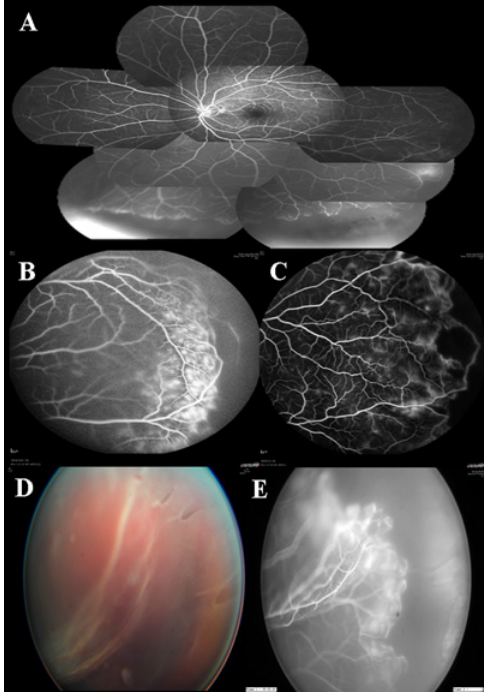
Fig 3. Color fundus and FA photos of group 3 eyes (A) Fluorescein angiography of an eye with group 3 retinal vasculature. Note there is anastomosis at the temporal and lower peripheral vasculature, with a wide non-perfusion at the temporal and lower aspect being noted. Vascular leakage is noted at some parts of the inferior and peripheral detached retina. (B) Another eye with type 3 vascular pattern showing circumferential route of peripheral vasculature, with peripheral non-perfusion, telangiectatic vessels and marked leakage. (C) Another eye with type 3 vascular pattern showing circumferential route and anastomosing vasculature forming a vascular loop with non-perfusion within the loop. Vascular leakage and telangiectasia were also noted. (D) Fundus photo of an eye with type 3 vascular pattern showing multiple tears without lattice degeneration. (E) Fluorescein angiography of the same patient showing that all the tears are in the peripheral non-perfused